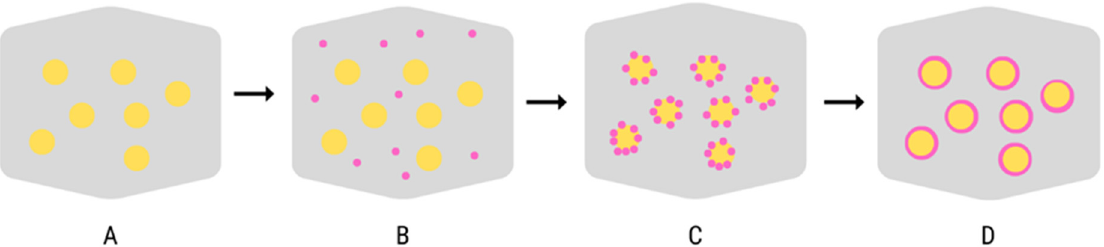
Figure 3. The mechanism of microcapsules formation in the coacervation method, liquid phase ( A ), suspending the core material in the liquid phase ( B ), deposition of liquid polymer around the core ( C ), gelling, and solidification of the microcapsule wall ( D ), own elaboration [43]. Coacervation has been classified into simple (SC) and complex coacervation (CC).